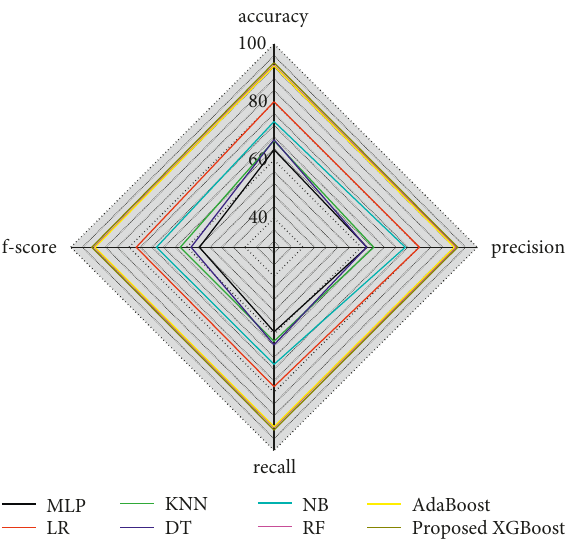
Figure 2: Performance parameter comparison of model XGBoost with other conventional models.